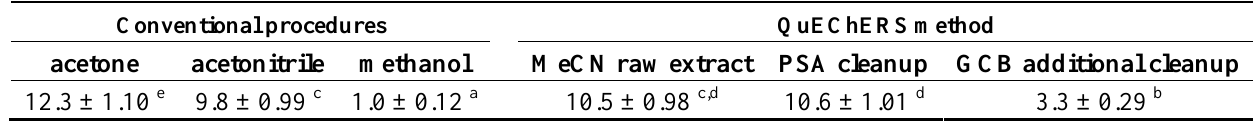
Table 2. Fucoxanthin contents (µg/mL) in the conventional extracts (acetone, acetonitrile, methanol) and in the extracts obtained with the QuEChERS method (acetonitrile raw extract, PSA cleanup, GCB additional cleanup).